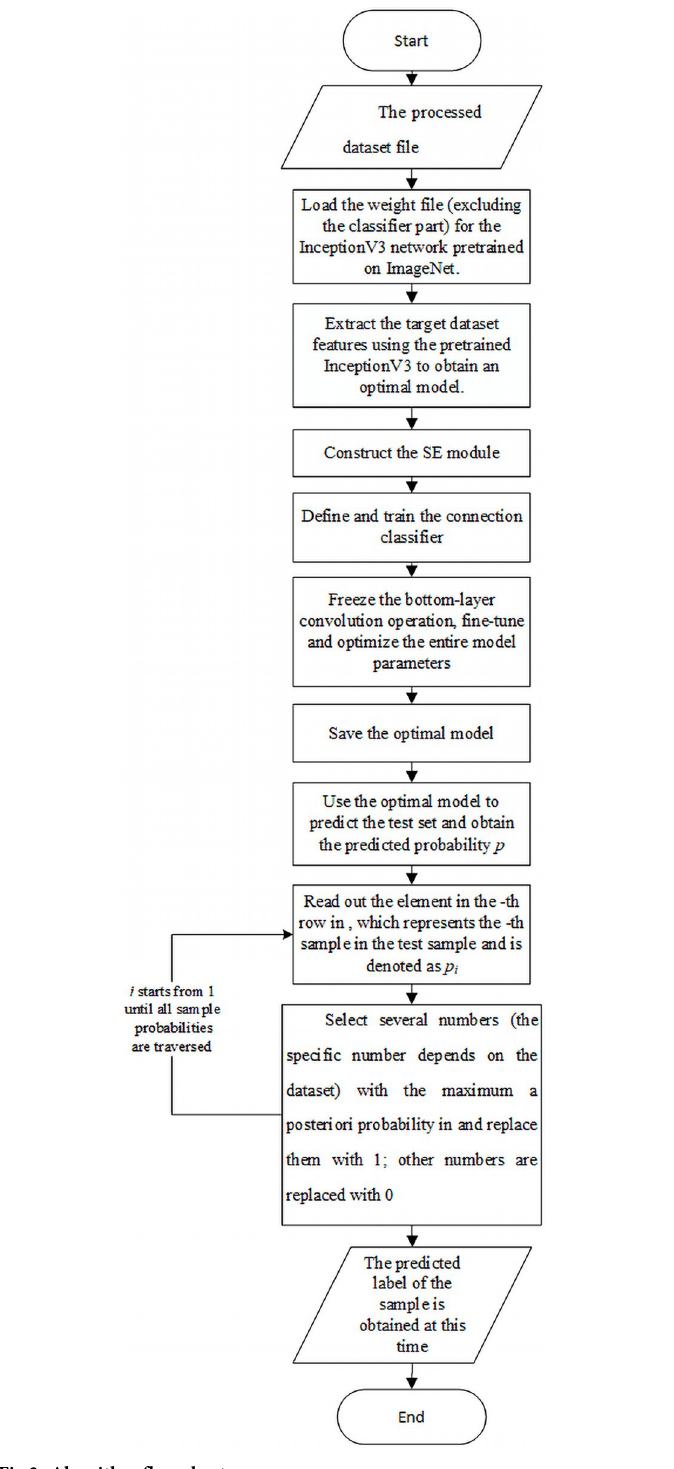
Fig 3. Algorithm flow